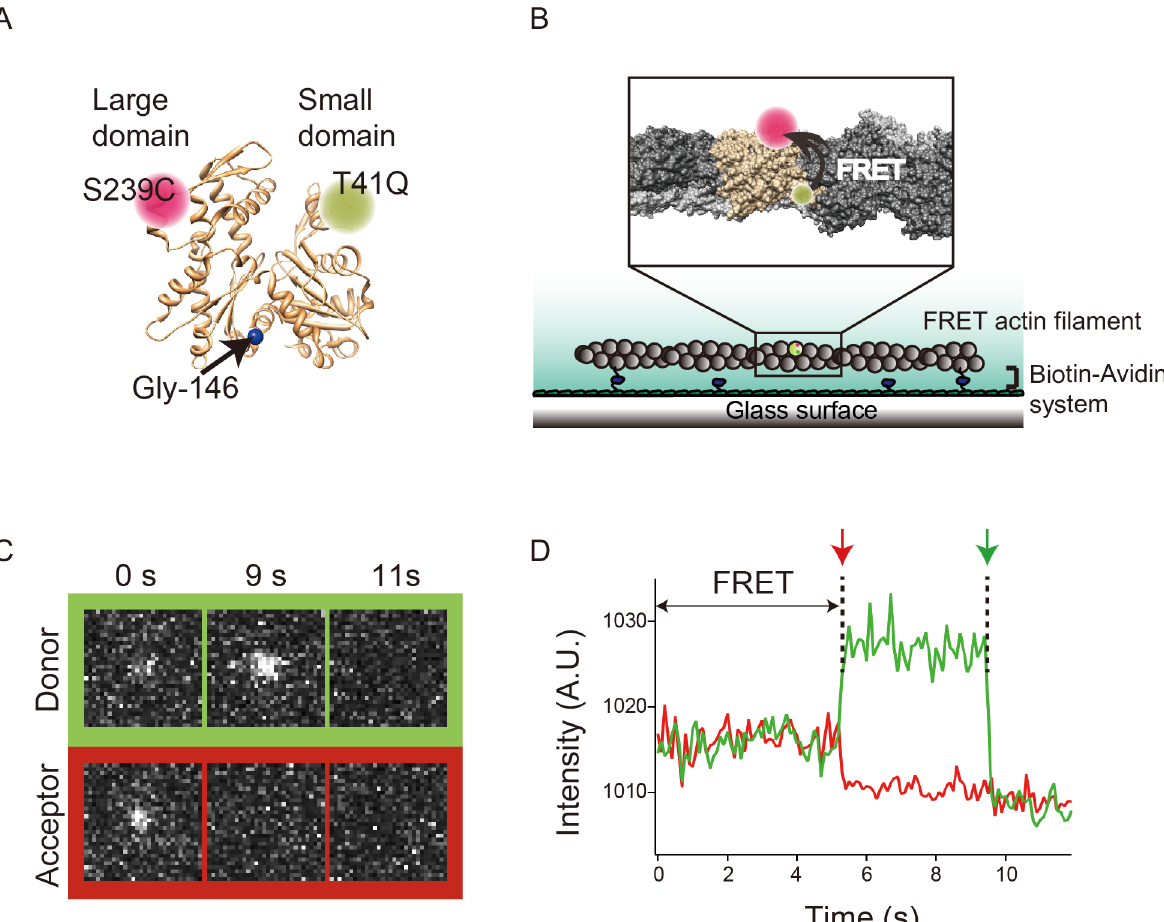
Fig 2. Intramolecular FRET measurement system. (A) Donor and acceptor fluorophores were introduced at the tips of the two major domains of WT actin and G146V actin (FRET actin). Actin monomer (PDB ID: 1c0f) [48] and filament (PDB ID: 3g37) [41] were drawn by using UCSF Chimera software. (B) FRET actins were copolymerized with excess amounts of WT or G146V actin, 0.9% of which was biotinylated, and they were immobilized on a glass surface by using the biotin — avidin system. (C and D) A typical series of time-lapse fluorescence images and fluorescence intensities of donor and acceptor from a single actin subunit in a filament in the absence of myosin. During FRET, fluorescence of the acceptor (red) was higher than that of the background, while that of the donor (green) was lower. Upon photobleaching of the acceptor (red arrow), the fluorescence intensity of the donor increased. Subsequently, the donor was also bleached (green